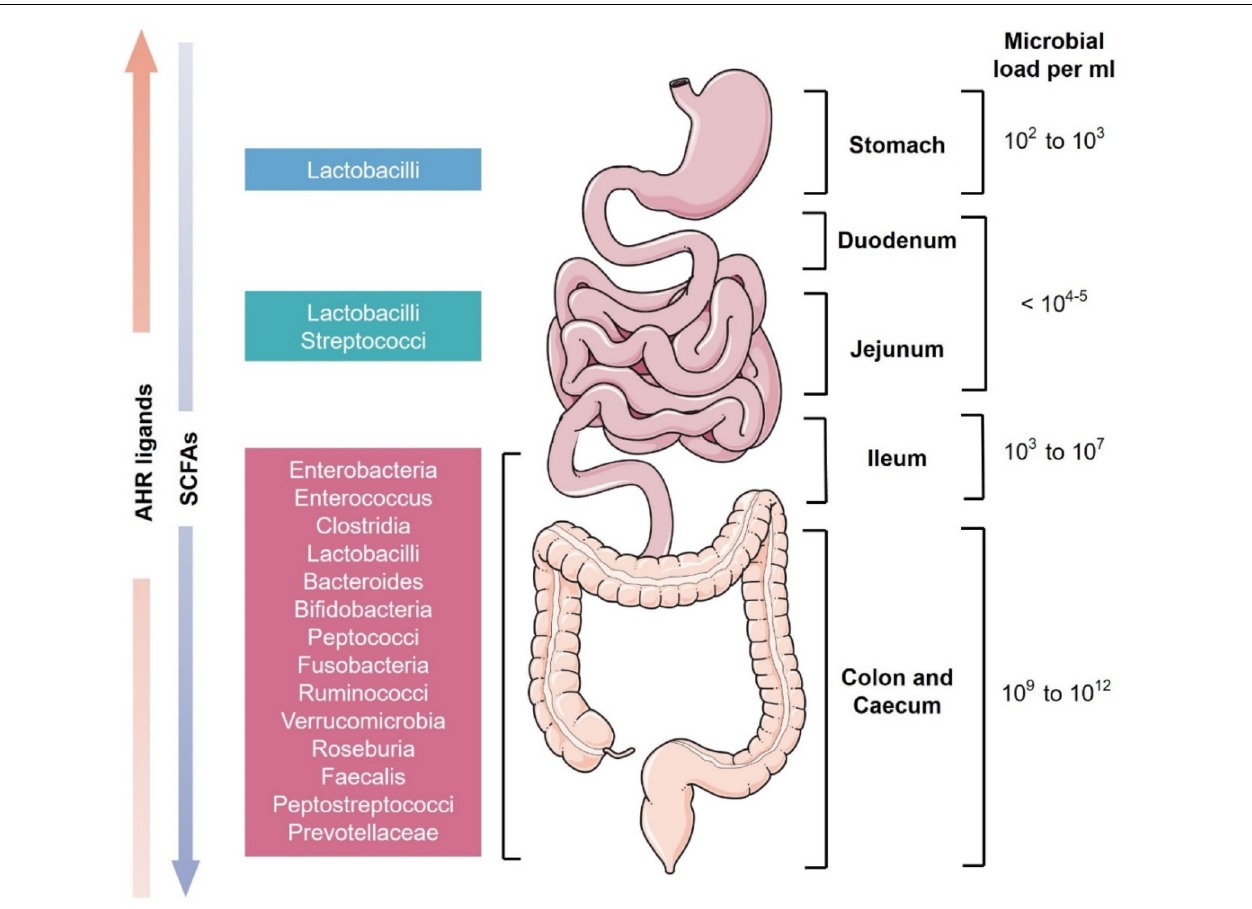
FIGURE 1 | Schematic representation of microbial diversity throughout the human gastrointestinal tract. The stomach has the least microbial diversity whereas the colon and cecum are the most diverse (Ahmed et al., 2007). These microbes produce various essential secondary metabolites from the diet like short-chain fatty acids (SCFAs) and aryl hydrocarbon receptor (AhR) ligands. SCFAs are present in higher levels in the colon while AhR ligands are more concentrated in the small intestine (Mowat and Agace,